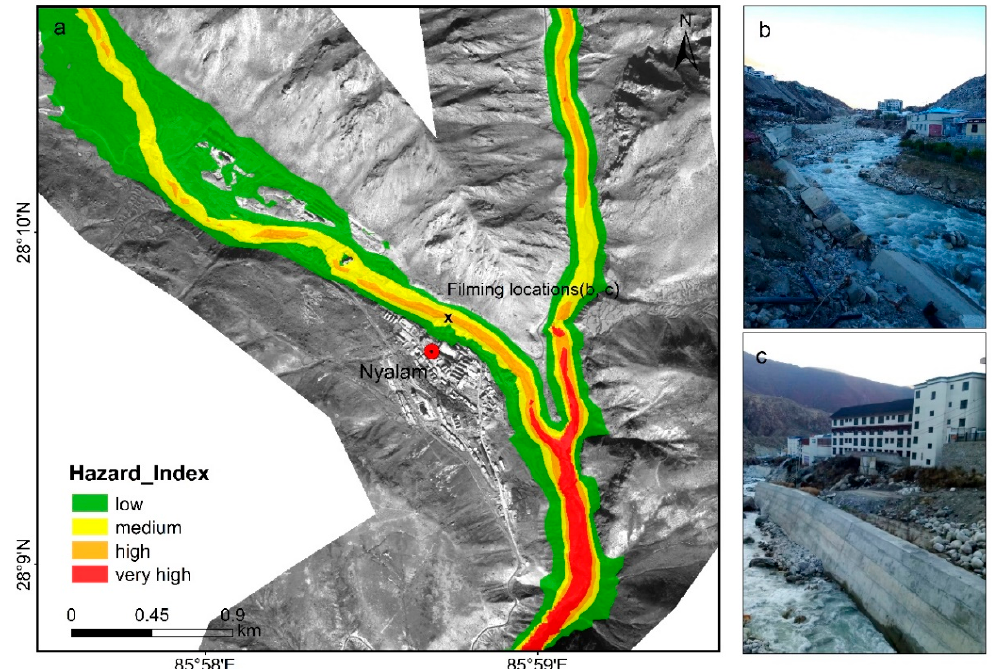
Figure 8. GLOF hazard levels in ( a ) Nyalam County and ( b , c ) along the river. ( b ) View upstream and ( c ) view